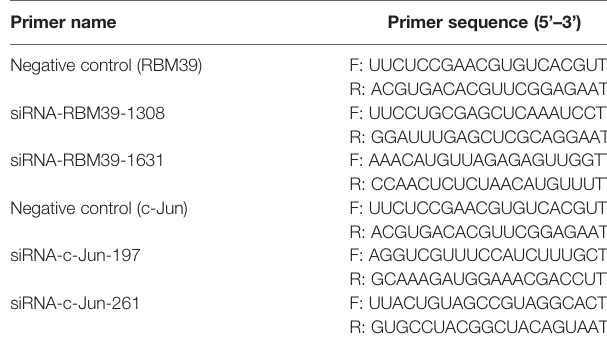
TABLE 3 | Primers used in RNA interference